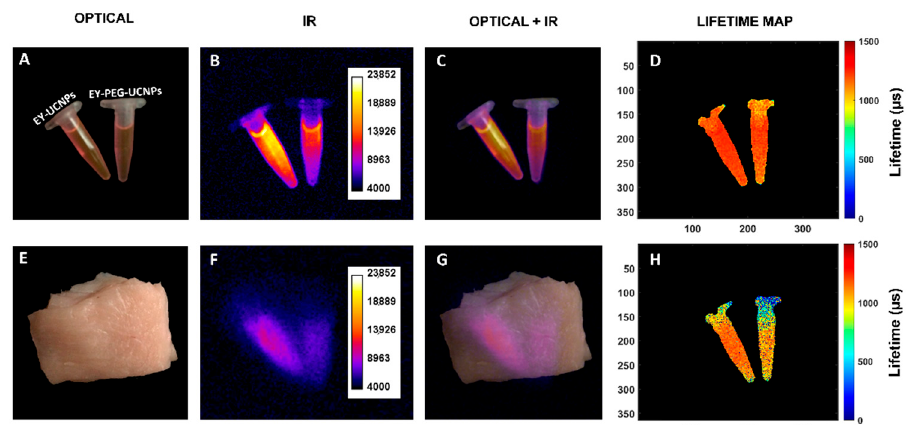
Figure 7. Intensity and lifetime fluorescence images of 1 mg/mL dispersions of EY-UCNPs and EY-PEG-UCNPs. First row: Visible image ( A ), NIR image ( B ), overlap between the optical and IR images ( C ) and lifetime maps ( D ) of EY-UCNPs and EY-PEG-UCNPs. Second row: visible image ( E ), NIR image ( F ), overlap between the optical and IR images ( G ) and lifetime maps ( H ) of EY-UCNPs and EY-PEG-UCNPs microtubes covered by 8 mm of chicken tissue.